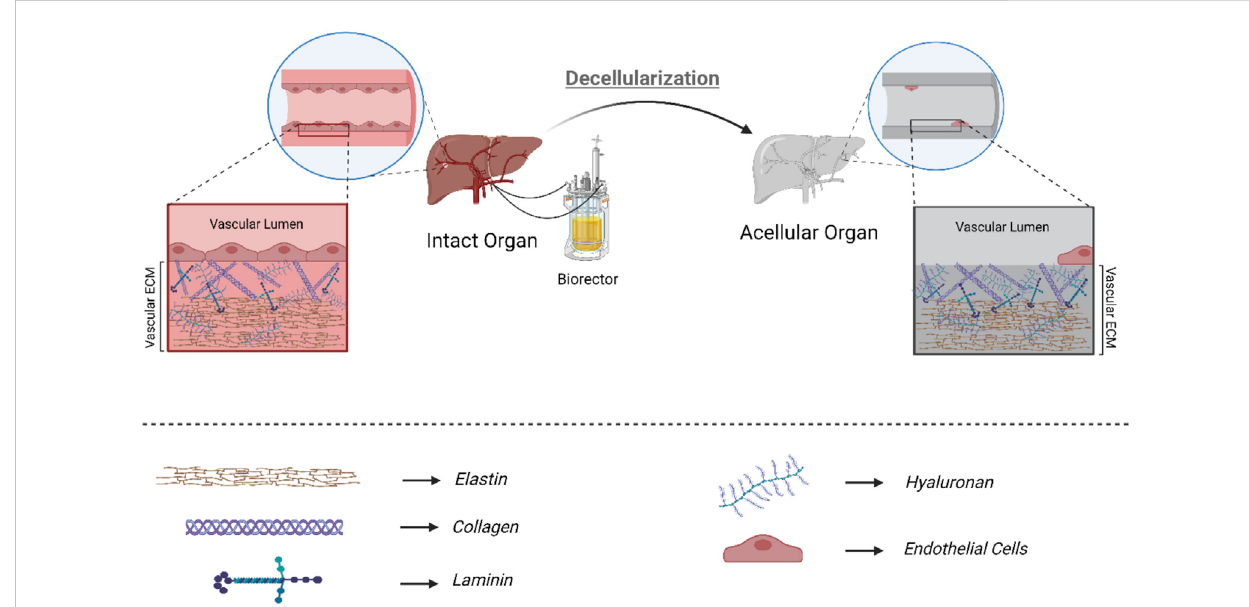
FIGURE 2 Detergent-based decellularization: Optimized detergent-based decellularization of biological scaffolds is done to clear away cells and cell debris completely,removingpotentialimmunogensandantigenspresentinthescaffoldwhilepreservingthestructuralandfunctionalproteinsthatmakeupthe extracellular matrix. Considering the ECM obtained from decellularization and the importance of the components present in ECM in regeneration, the more intact the fi nal product of decellularization is, the better the results of recellularization, endothelialization, and fi nal tissue function will